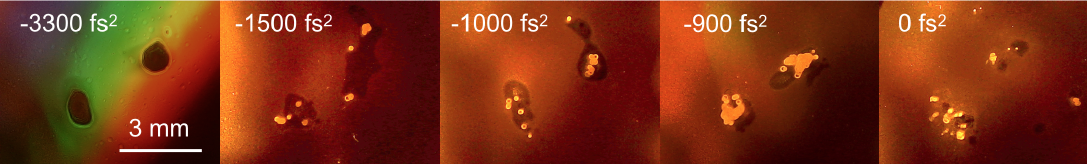
Figure 5. Burn profiles recorded on a compact disc surface with respect to change in the quadratic phase of the incident laser pulse. The burn profiles are produced with 40 laser shots at the target